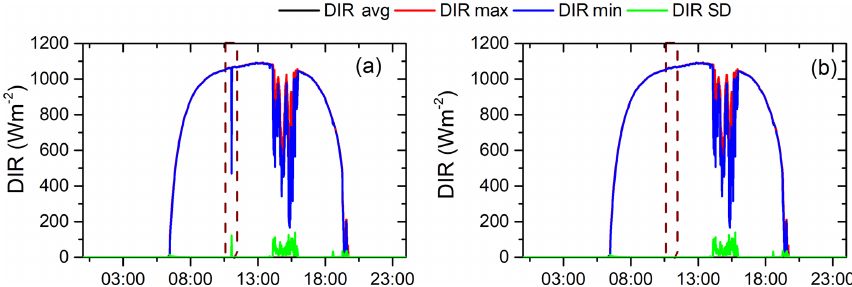
Figure 8. Example of data-removing process. The rejected data were caused by shadows during cleaning operations. The dashed line repre- sents the pyrheliometer cleaning time (a) before removing rejected data and (b) after removing rejected data. Table 5. Same as Table 4 except for the “comparison” intervals used for flagging the radiation quantities. σ is the Stefan–Boltzmann